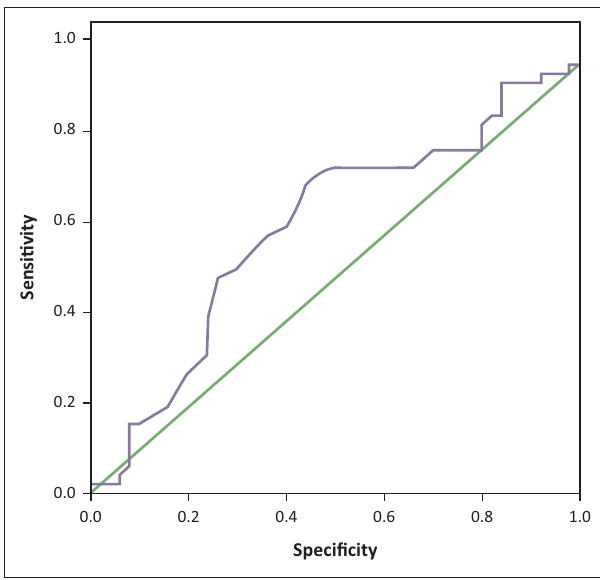
FIGURE 4: Receiver operating characteristic curve analysis to evaluate red blood cell distribution width utility in discriminating between inflammatory bowel disease and irritable bowel syndrome patients, Babol, Iran 2015–2017.